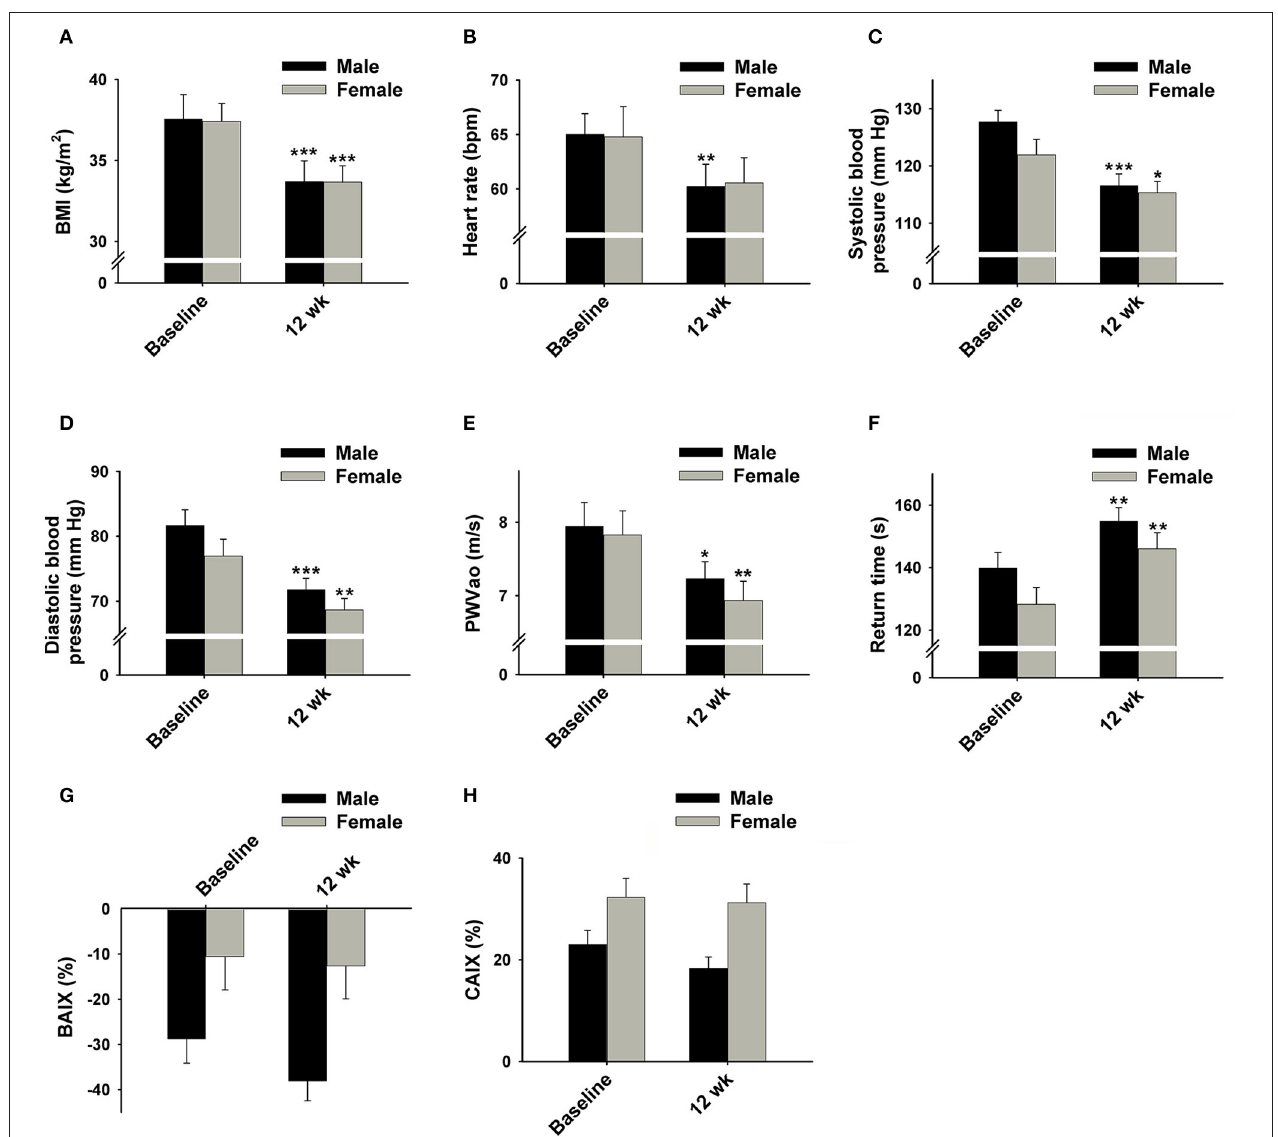
FIGURE 4 | Effect of 12 week HP-IF-LC intervention (Phase 1) on (A) BMI, (B) heart rate, (C) systolic blood pressure, (D) diastolic blood pressure, (E) PWVao, (F) return time (the time intervals between peaks from the early direct and reflected late systolic waves), (G) BAIX, and (H) CAIX of males and females. Significant difference compared to baseline of the same gender indicated by: * p < 0.05; ** p < 0.01; *** p < 0.001. BMI, body mass index; PWVao, aortic pulse wave velocity; BAIX, brachial augmentation index; CAIX, central augmentation index.